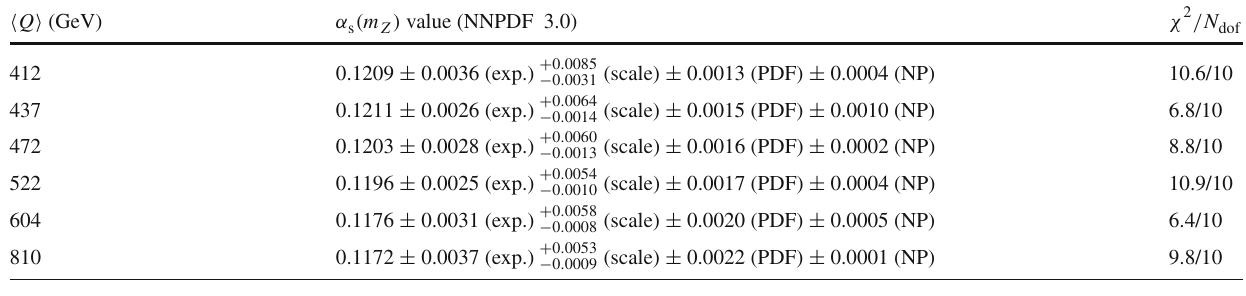
column, while the values of the χ 2 function at the minimum are shown in the third column. The uncertainty referred to as NP is the one related to the non-perturbative corrections